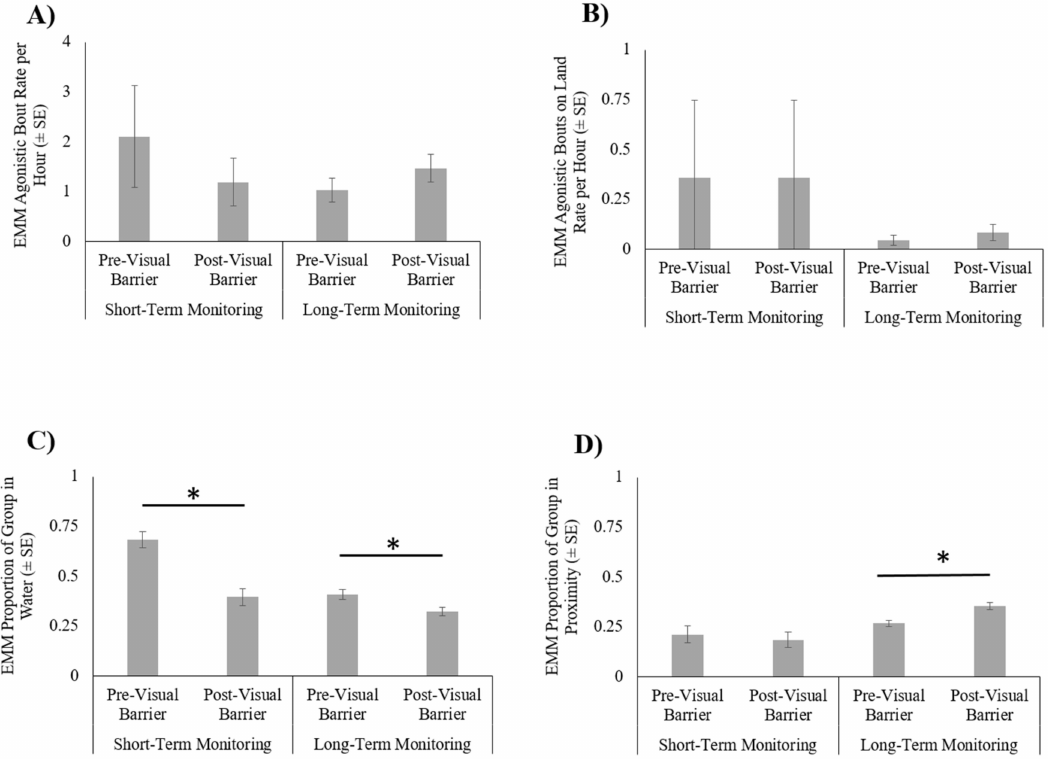
Figure 2. Crocodile behavior (estimated marginal mean (EMM) ± SE) pre- and post-visual-barrier installation during both short- and long-term monitoring periods. ( A ) Rate of agonistic bouts. ( B ) Rate of agonistic bouts on land. ( C ) Proportion of group in water. ( D ) Proportion of group in proximity to conspecific. Asterisks (*) denote statistical significance ( p ≤